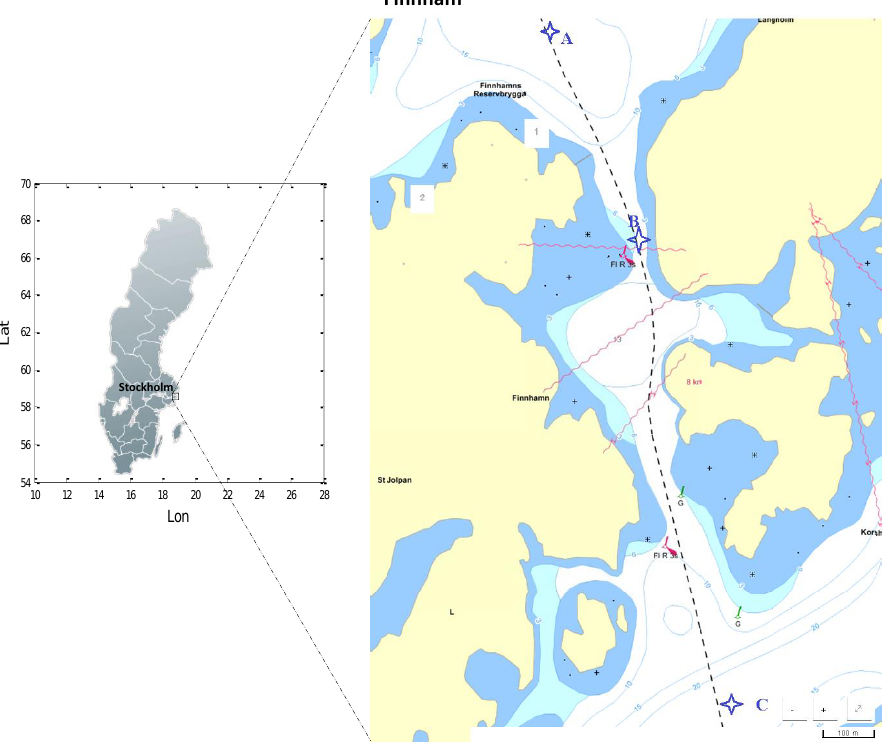
Figure 1. Map showing the surveyed site. Finnhamn Island is seen to the left in the inset. The survey path is marked with a dotted line. Measurement points A, B and C are denoted by stars. Scale: 100 m (courtesy of Sjöfartsverket).